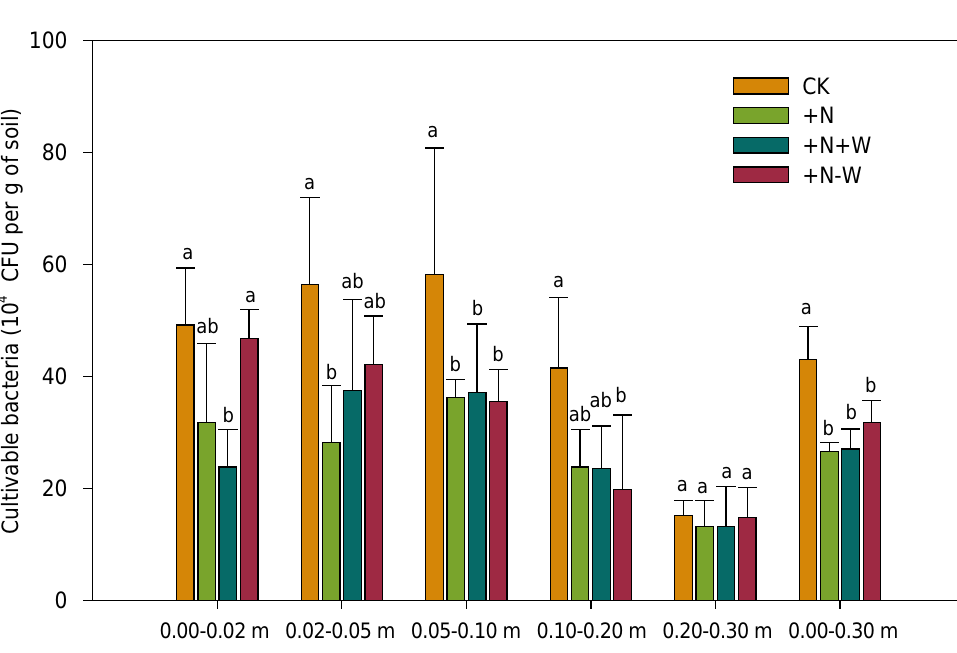
Figure 2. The number of cultivable bacteria at each soil layer in different treatment groups. Note: numbers with the same letter are not significantly different at